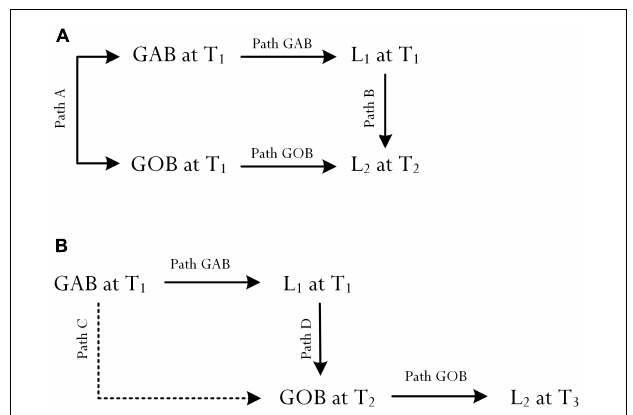
FIGURE 2 | Association between goal of actual best (GAB) and goal of optimal best (GOB). L1 = Actual best, L2 = Optimal best, T1 = Time 1, T2 = Time 2, T3 = Time 3, GAB = Goal of actual best, and GOB = Goal of optimal best. (A) shows both GAB and GOB situated at T 1 (i.e., correlation between GAB and GOB) and (B) shows that GAB at T 1 precedes GOB at T 2